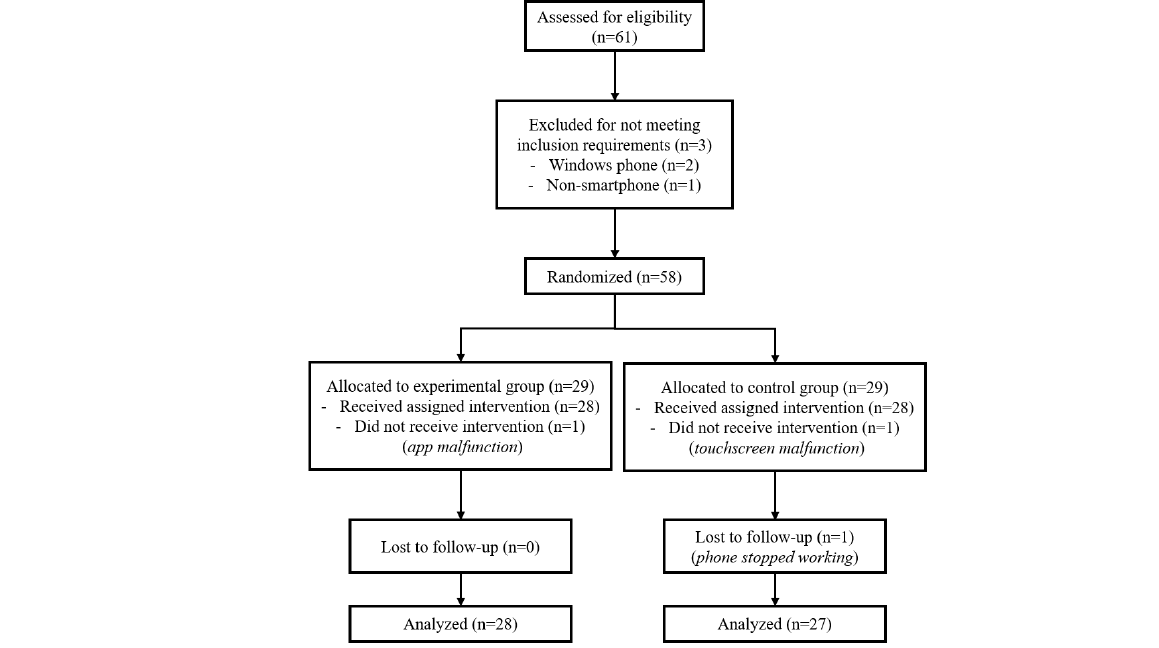
Figure 2. Accupedo Pedometer app screen